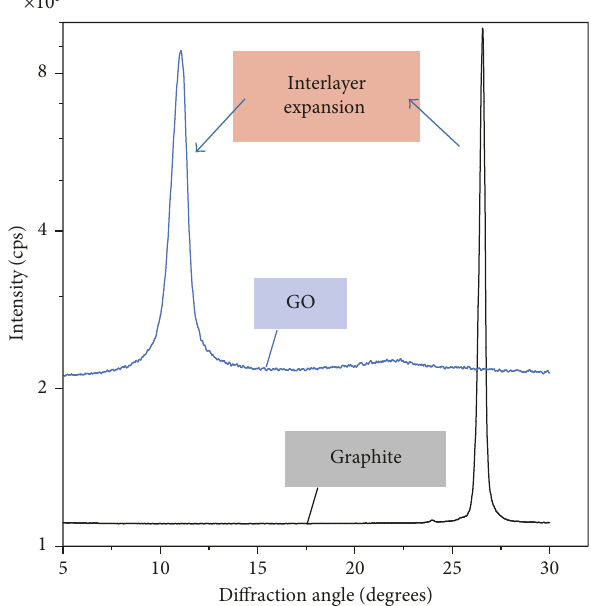
Figure 1: X-ray diffractograms of graphite and graphite oxide powders. For clarity, patterns are offset along the y -axis, and for graphite, it was divided by